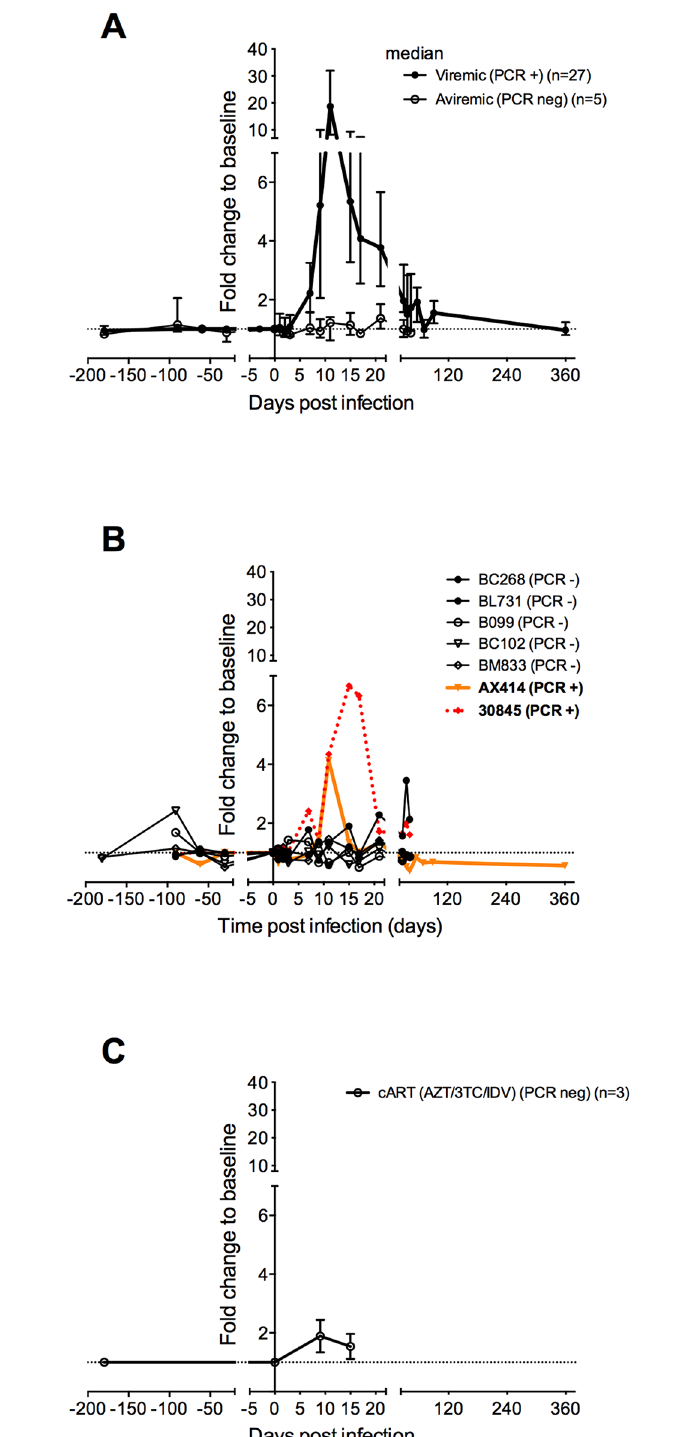
Fig 5. Dynamics of IP-10 levels in viremic and aviremic animals. IP-10 levels in plasma were determined in a longitudinal study, before infection and after SIVmac251 challenge in cynomolgus macaques. Values are expressed as the fold change from baseline (median of 3 to 4 values obtained before infection). A. IP-10 dynamics in 27 viremic and 5 SIV-exposed aviremic animals are shown (median and interquartile range). The latter had no detectable SIVmac DNA in lymph nodes. B. Blood IP-10 dynamics in 2 aviremic animals with